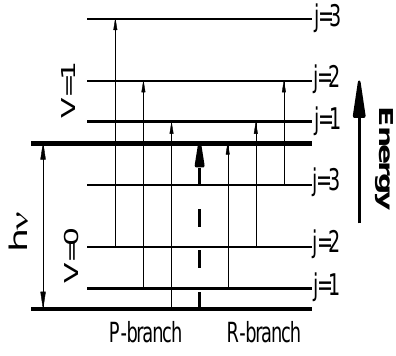
Figure 3. Diagram of energy inter-level transitions for a diatomic